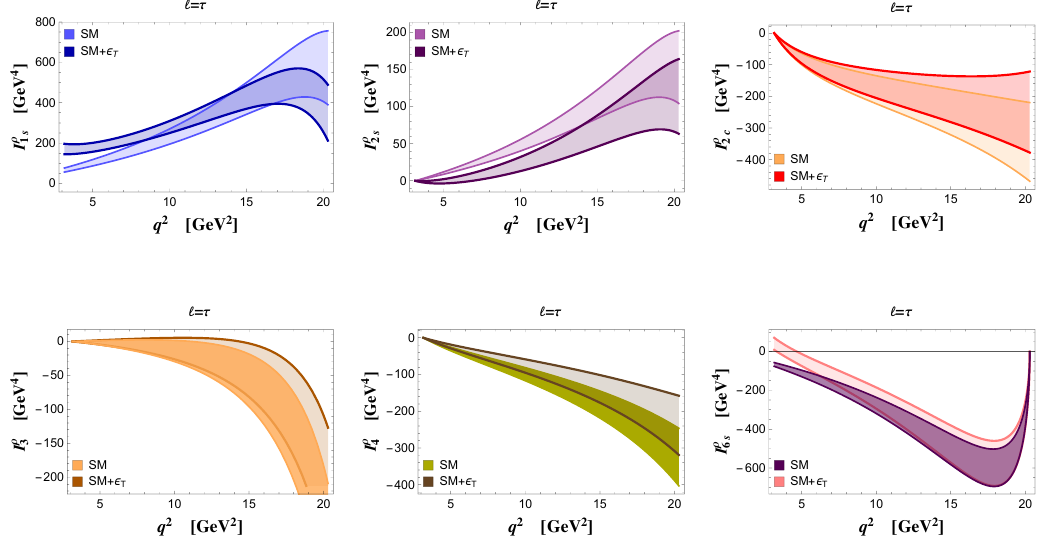
( q 2 ) in Equation (5). The bands for i